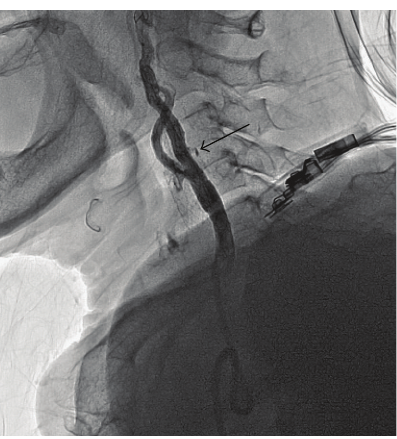
Figure 6: Left carotid angiography after stent deployment shows no residual stenosis in the internal carotid artery (black